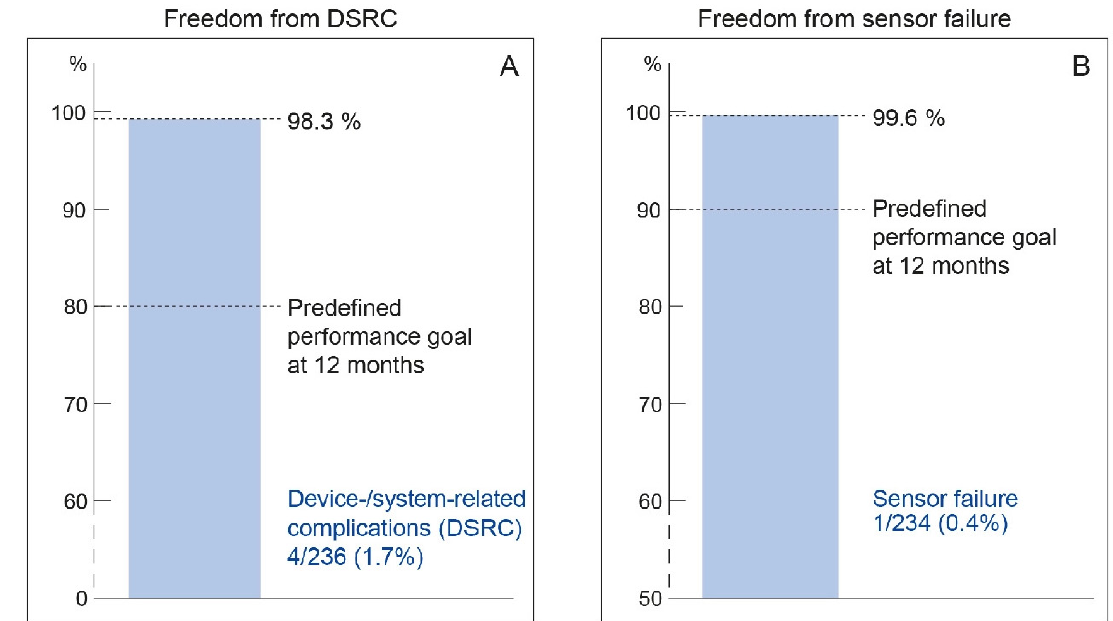
Figure 8. Primary safety endpoints as reported in MEMS-HF (CardioMEMS European Monitoring Study for Heart Failure). Adapted from European Journal of Heart Failure, Volume 22, Issue 10, Angermann et al., Pulmonary artery pressure-guided therapy in ambulatory patients with symptomatic heart failure: the CardioMEMS European Monitoring Study for Heart Failure (MEMS-HF), Pages 1891–1901, with permission from Wiley [29]. DSRC, device- or system-related complications.